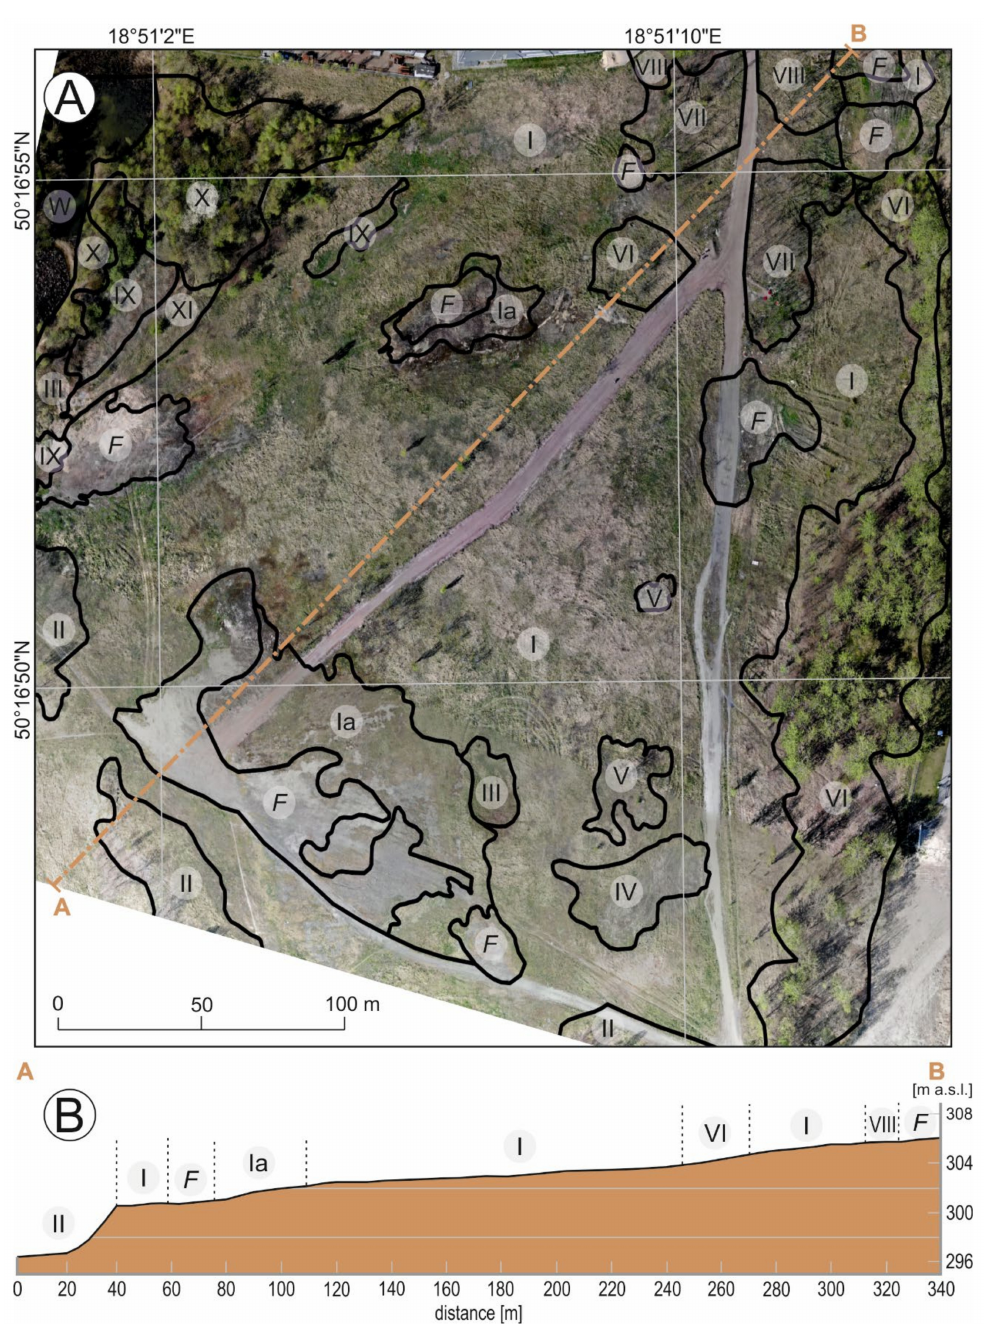
Figure 7. Vegetation map ( A ) on the orthophotomap (29 March 2019) and altitude profile ( B ) of the D-RS-1 coal-waste dump: I: mixed community with Erigeron annuus , Calamagrostis epigejos , and Solidago canadensis ; IA: initial form of community near the fire zone; II: community with Robinia pseudoacacia ; III: community with Rubus caesius ; IV: community with Verbascum thapsus ; V: community with Solidago canadensis and Robinia pseudoacacia ; VI: stand with Populus × canadensis ; VII: community with R. pseudoacacia ; VIII: community with R. pseudoacacia and Pinus sylvestris ; IX: community with Phragmites australis ; X: community with Populus tremula , Salix caprea , and S. fragilis ; XI: community with Phragmites australis - Solidago canadensis ; and F—thermally active zones without plant